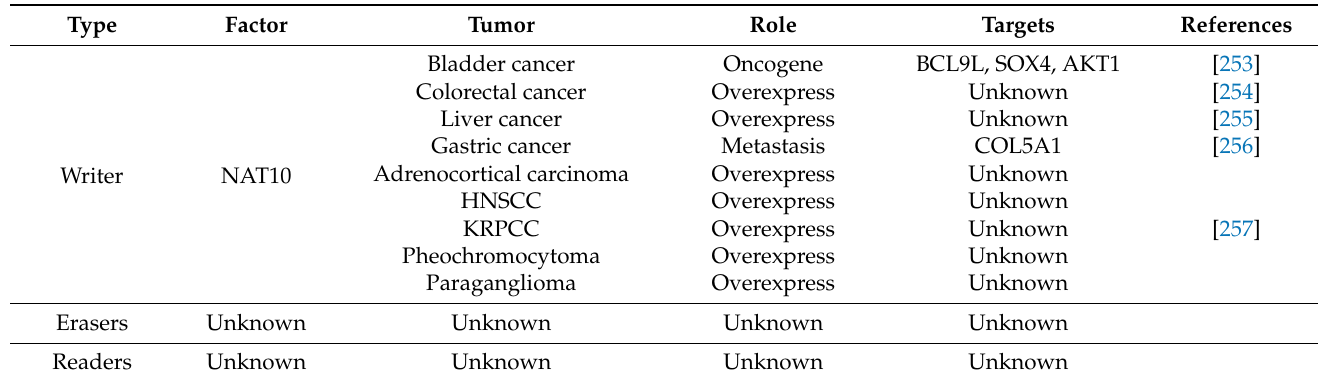
Table 6. Role of ac 4 C in cancer. HNSCC—head and neck squamous cell carcinoma; KRPCC—kidney renal papillary cell